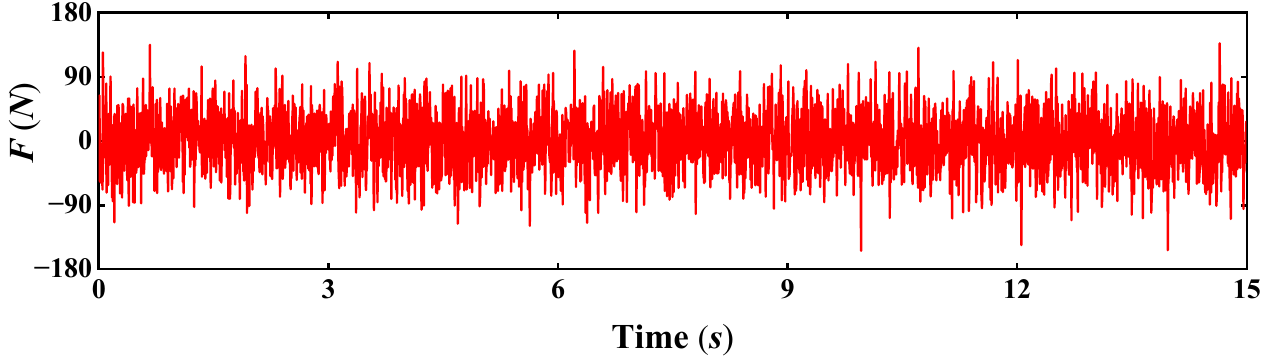
Figure 6. Gaussian white noise time history.